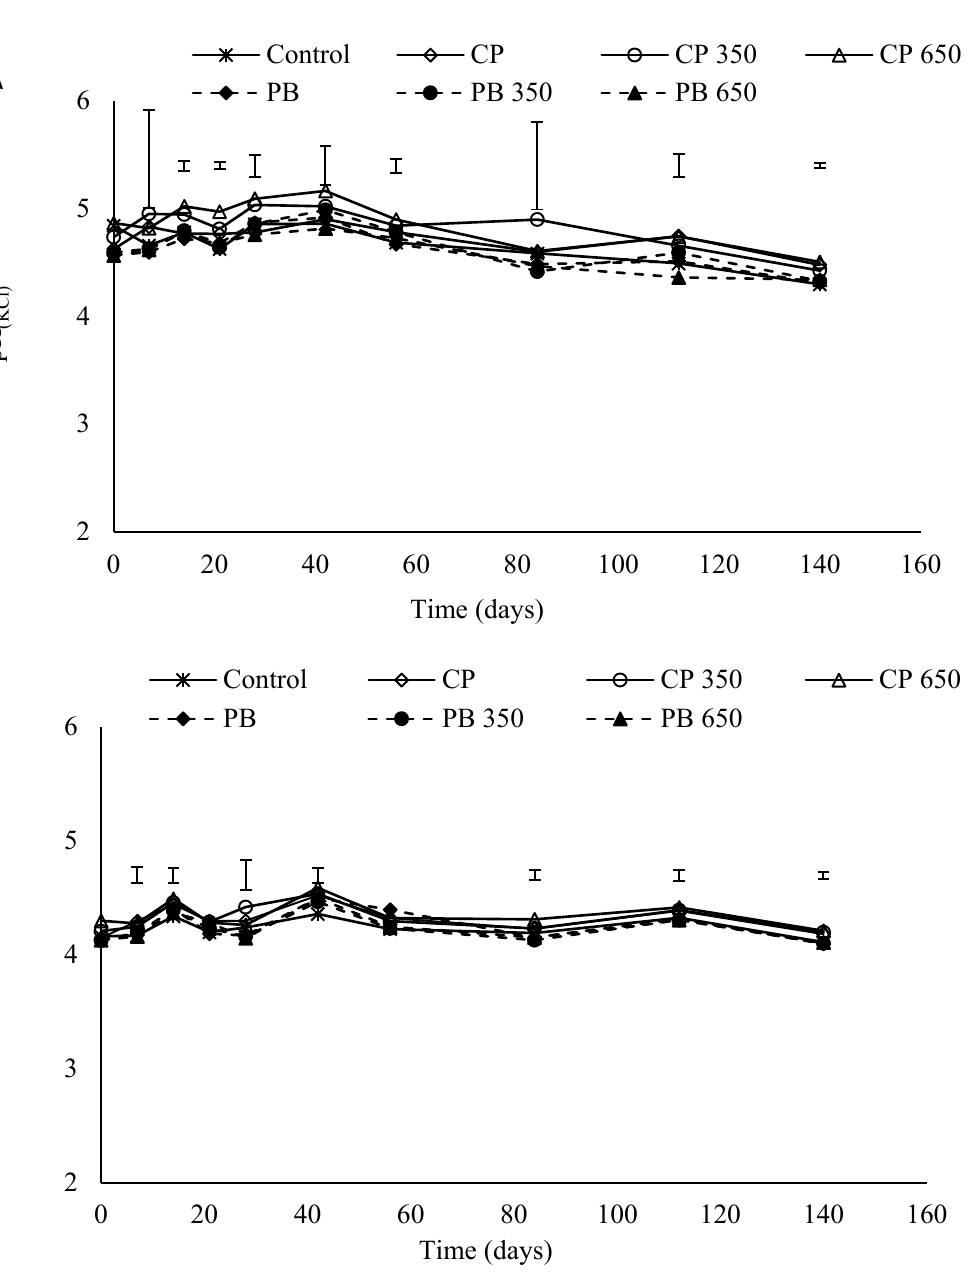
Figure 9. The pH (KCl) during incubation of ( A ) Luvisol and ( B ) Ferralsol amended with biochar from cull potato (CP) and pine bark (PB) produced at varying pyrolysis temperature. CP = cull potato; PB = pine bark; CP 350 = cull potato biochar at 350 ◦ C; CP650 = cull potato biochar at 650 ◦ C; PB 350 = pine bark biochar at 350 ◦ C; PB 650 = pine bark biochar at 650 ◦ C. The vertical error indicates LSD ( p < 0.05).